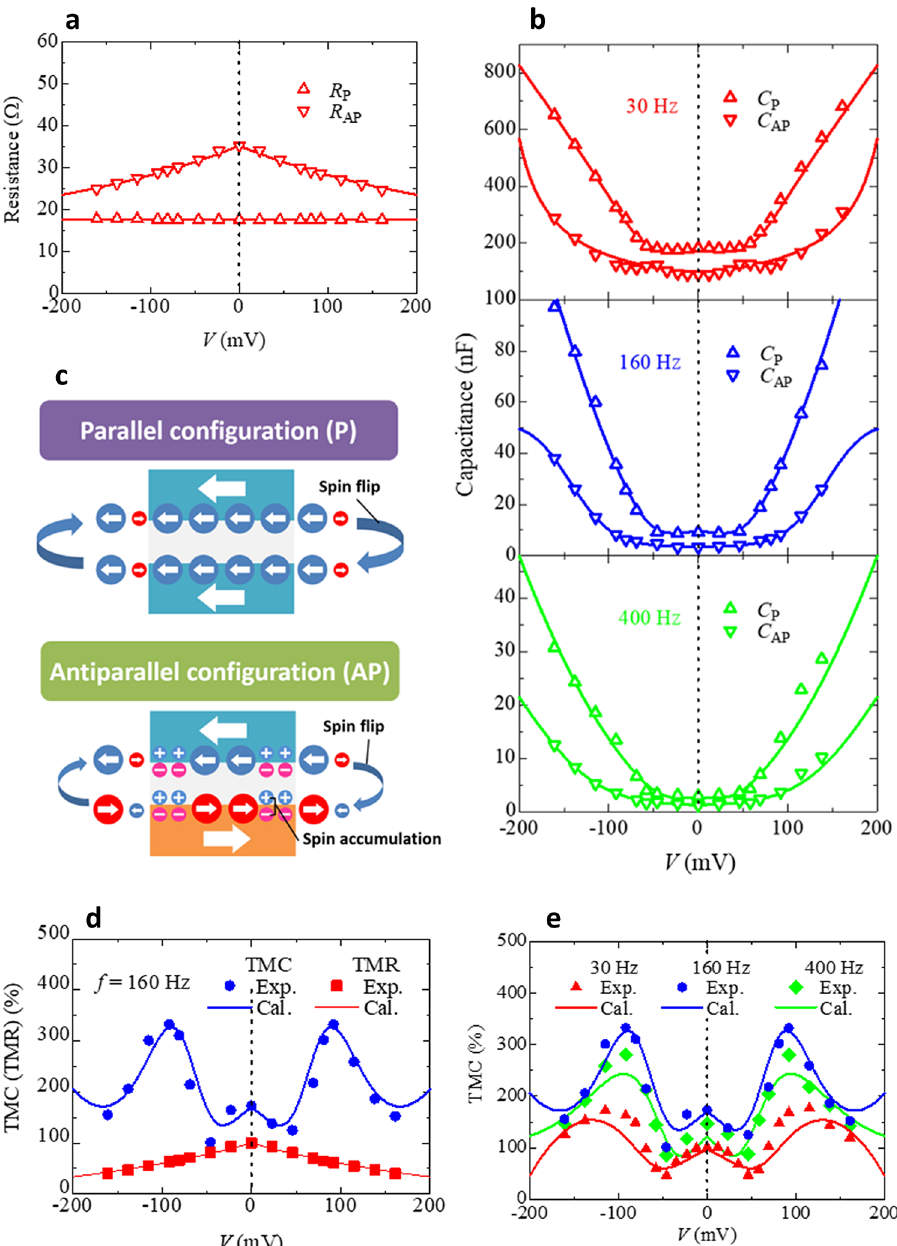
Figure 4. Bias dependence of TMC and TMR. ( a ) DC voltage dependence of the resistance R P(AP) in the P(AP) configuration. The calculation of R P(AP) is performed using Zhang’s theory, represented by the solid lines. ( b ) DC voltage dependence of the capacitance C P(AP) in the P(AP) configuration at 30, 160, and 400 Hz. The C P(AP) as represented by the solid lines is calculated using the DF model incorporating the PBA and the Zhang-sigmoid model, as described by Eqs. (1)–(10). ( c ) Schematics of the Zhang-sigmoid model explaining C P(AP) . ( d ) A comparison of bias dependent TMR and TMC at 160 Hz. ( e ) Bias dependence of TMC at 30, 160 and 400